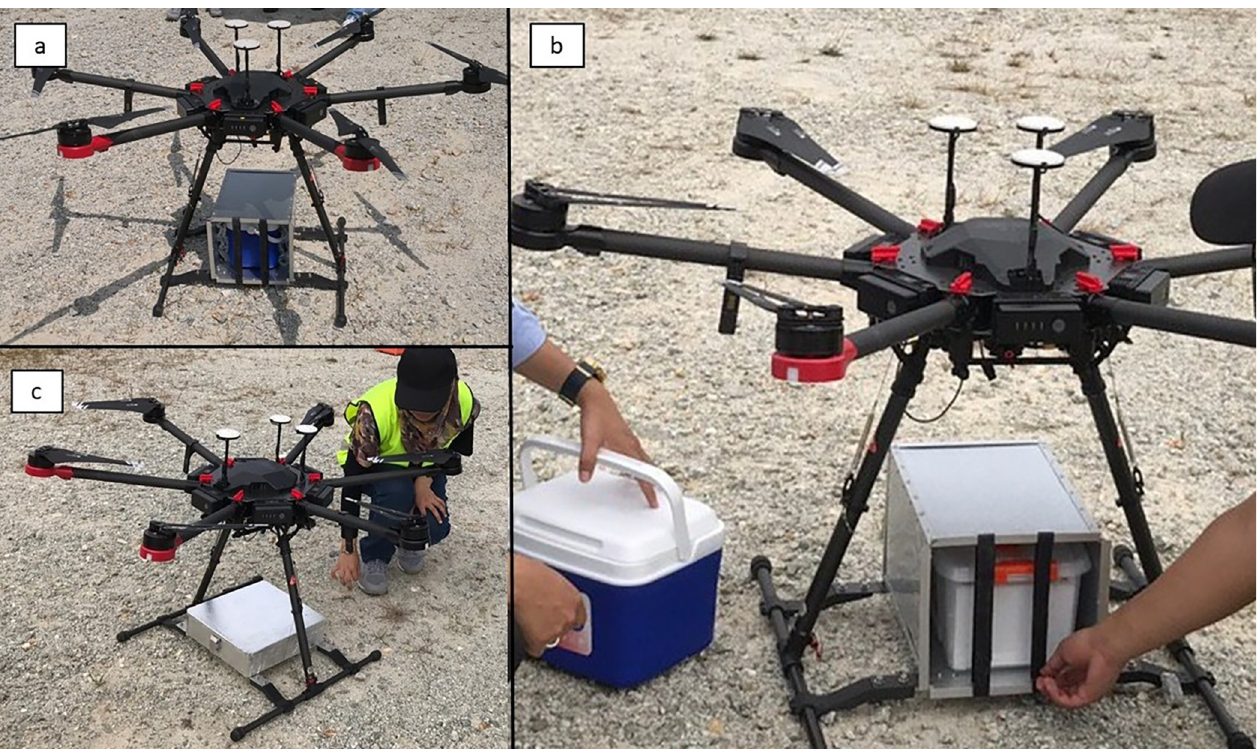
Fig 3. Attachment of carriages to drone. (a) Drone carriage made from EPS foam was attached to drone using a custom-made steel box with air cushion bags. (b) Drone carriage made from PP plastic was attached to drone using similar method as EPS foam. (c) Drone carriage made from aluminium was attached directly to drone using customized steel